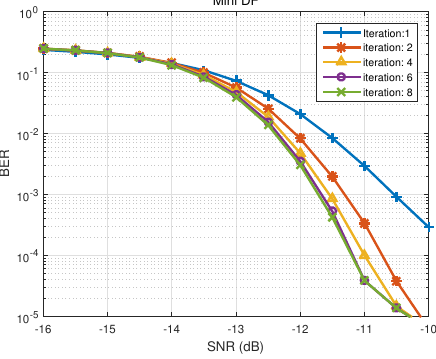
Figure 16. BER results for Mini